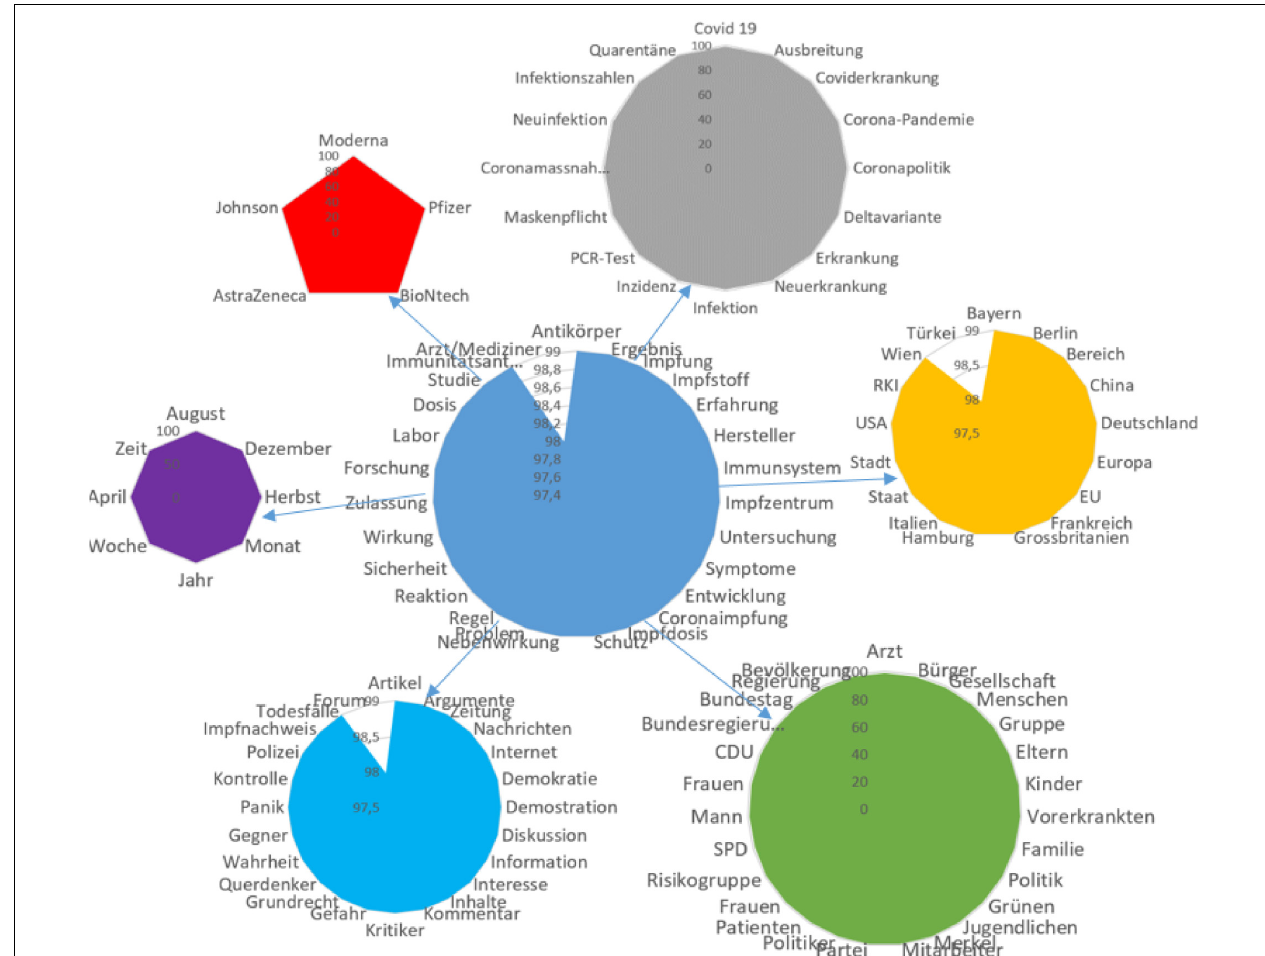
FIGURE 4 | Features of vaccine production and specificity of